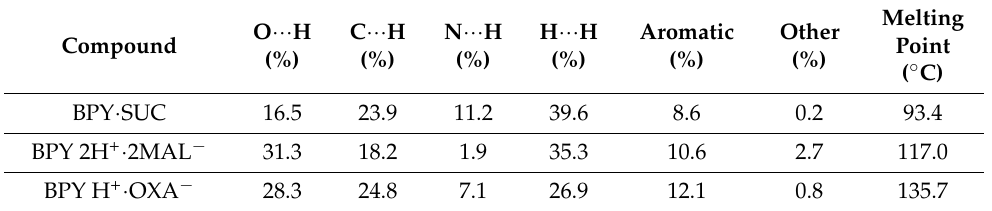
Table 3. Percentage contributions of the main interactions in BPY H + · OXA − , BPY 2H + · 2MAL − and BPY · SUC as well as the melting points of the compounds.